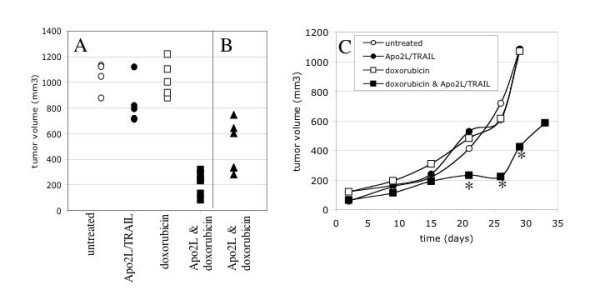
Effect of combination therapy on the growth of PC3 xenografts Mice bearing PC3 xenografts were untreated or treated with 4 mg/kg doxorubicin (i.p.), followed by either vehicle or 500 μg Apo2L/TRAIL (i.p.). Data shown represent tumor size twenty-six days after treatment was initiated (A). Tumor size in animals treated with combination therapy was monitored an additional week (33 days after treatment initiation) (B). Tumor growth over time (C) demonstrates that tumor growth is significantly different on and after day 21 (* indicates p < 0.05).